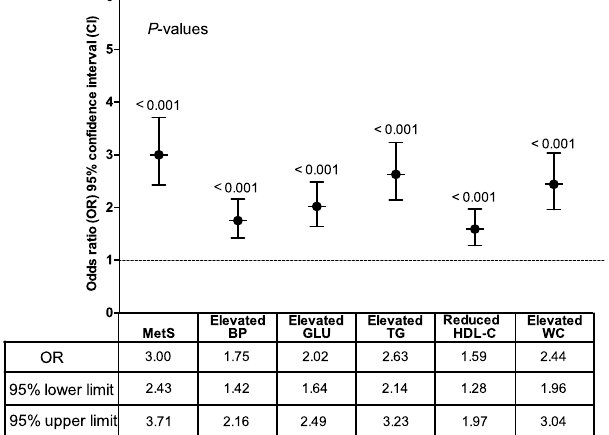
Figure 2. Association between abnormal liver function and MetS in rural areas located in Southwest China. Abnormal liver function increased the risk of MetS (OR = 3.00, 95% CI: 2.43–3.71) and all its constituents after adjustment for age, sex, HBV infection, Aflatoxin B1 exposure, MC-LR exposure, alcohol drinking, cigarette smoking, labor strength, education level, family income, and fat, salt, vegetable and fruit